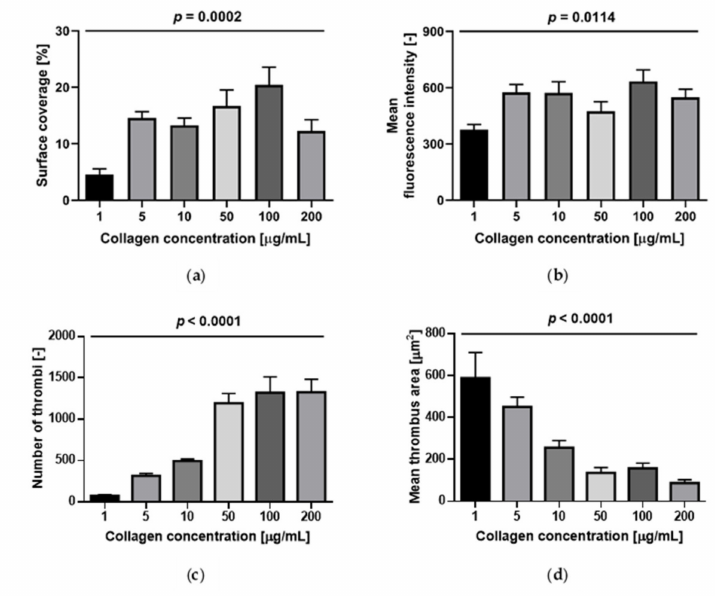
Figure 4. E ff ect of collagen concentration on platelet accumulation at 300 / s ( n = 7). ( a ) Surface coverage; ( b ) mean fluorescence intensity; ( c ) number of thrombi; ( d ) mean thrombus area. Data are represented as column bar graphs, with means ± standard errors of the mean, and analyzed by ANOVA tests plus Bonferroni’s multiple comparison post-hoc tests. Internal Contrast: ( a ) 1 vs. 5 µ g / mL of collagen, p < 0.05; 1 vs. 50 µ g / mL of collagen, p < 0.01; 1 vs. 100 µ g / mL of collagen, p < 0.001; ( b ) 1 vs. 100 µ g / mL of collagen, p < 0.05; ( c ) 1 vs. 50, 100 and 200 µ g / mL of collagen, p < 0.001; 5 vs. 50, 100 and 200 µ g /